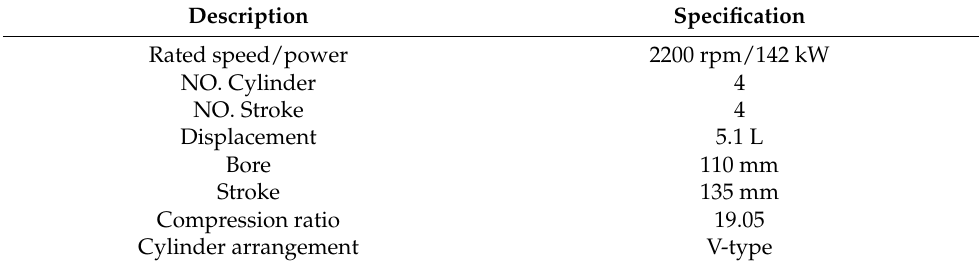
Table 1. Test engines specifications.